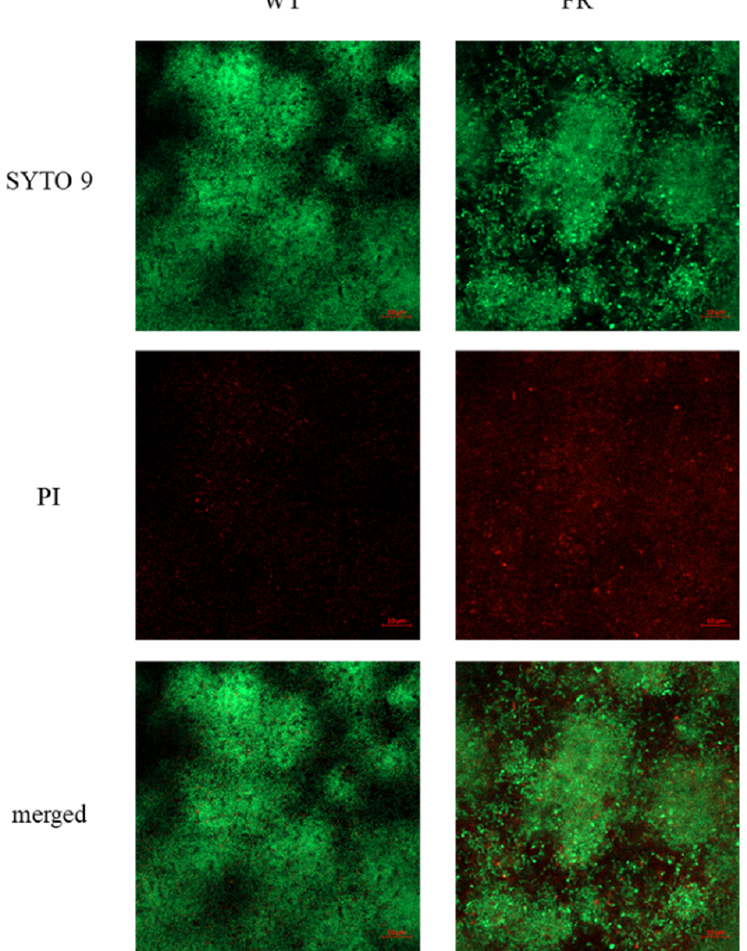
Figure 4. Comparison of biofilm formation between S. mutans wild-type and FR strains. S. mutans wild-type and FR strains were grown to an OD 600 value of 0.3 in BHI broth, diluted 1:100 in semi- defined BM supplemented with 18 mM glucose and 2 mM sucrose, and incubated at 37 ◦ C in a 5% CO 2 atmosphere for 24 h. Biofilms of wild-type and FR strains were observed using the LSM-800 CLSM, after staining using the LIVE/DEAD BacLight Bacterial Viability Kit. Images presented are a representative set of three independent